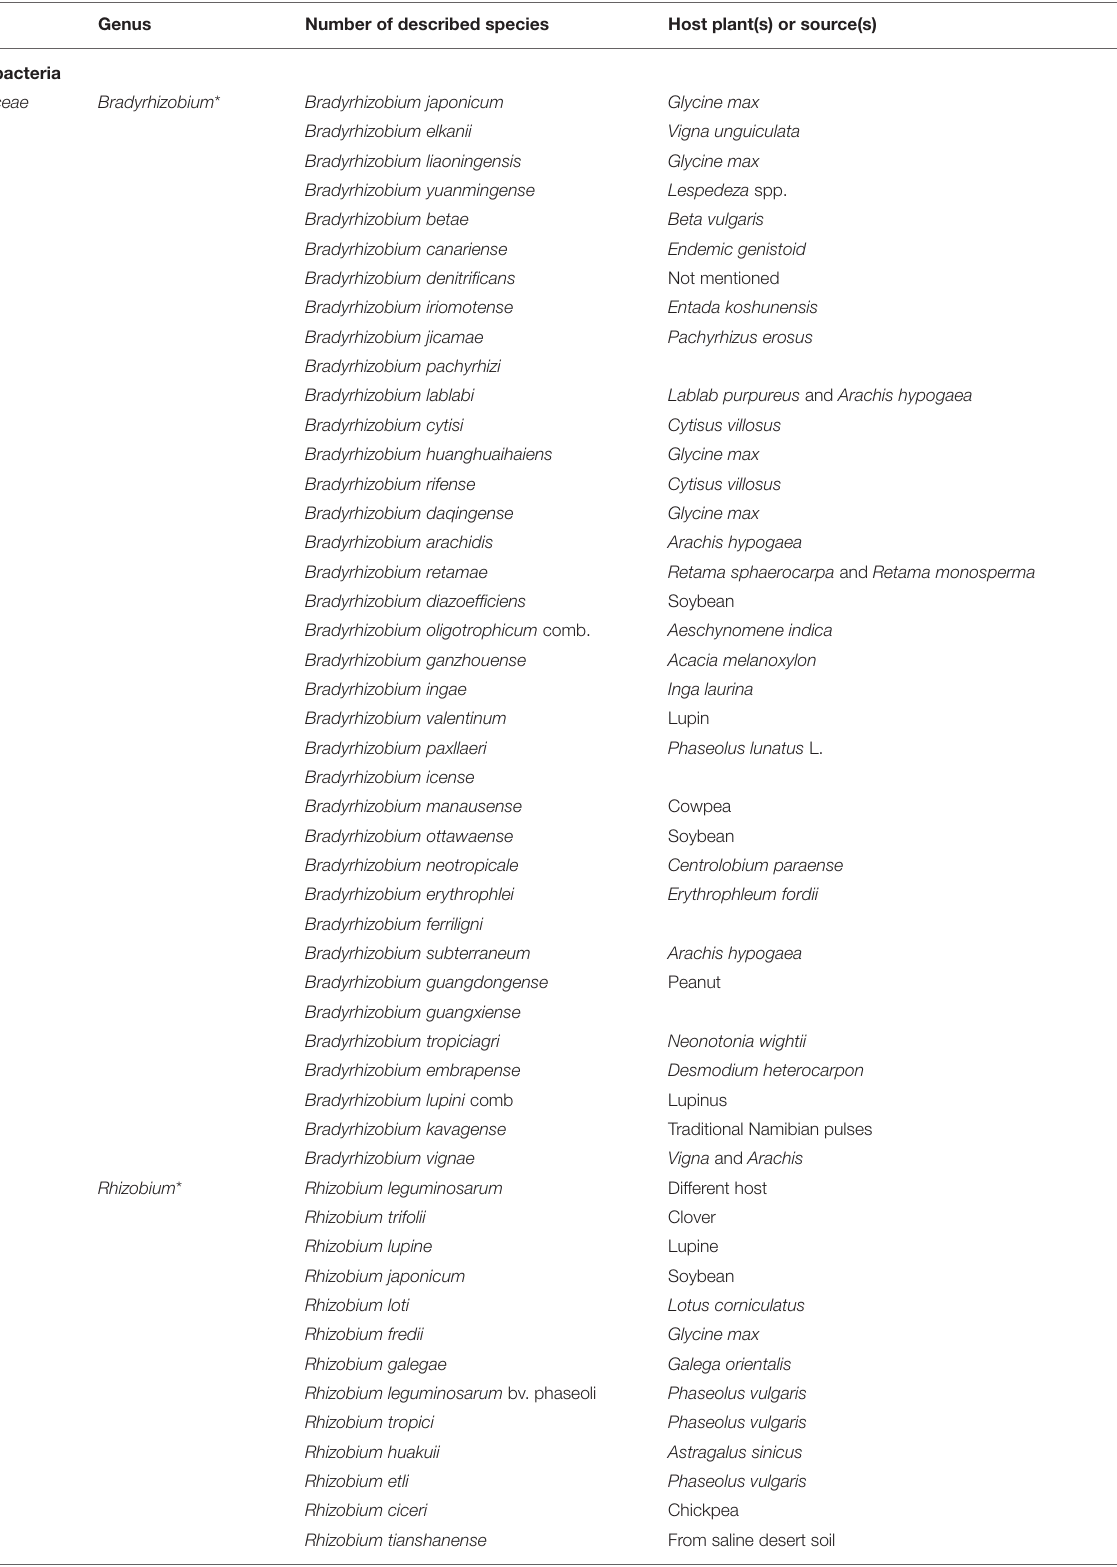
TABLE 1 | Families, genera, and species of root nodule rhizobia and their host plant(s) or source(s).